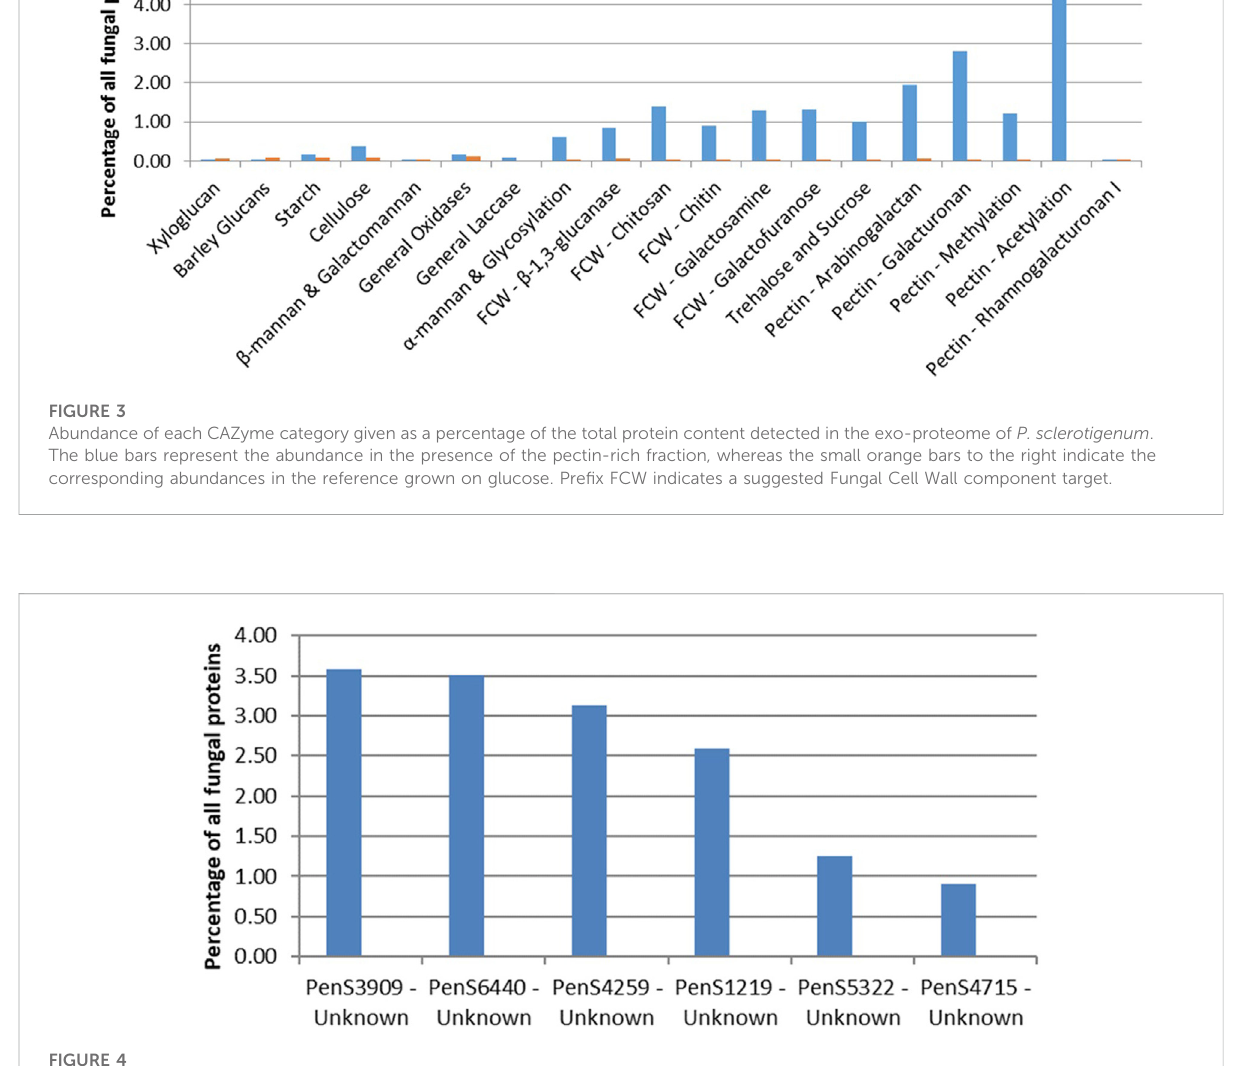
FIGURE 4 Protein abundances in the exo-proteome of six potentially new pectin active enzymes, all with predicted signal-peptide. The percentage level ofeachprotein,shownasbluebars,isgivenastheabundanceofthegivenproteinrelativetothetotalabundanceofallproteinsobservedintheexo- proteome of P. sclerotigenum . PenSxx-numbers refer to protein accession numbers. The protein accession numbers match accession numbers of speci fi c predicted proteins encoded by the genome of P. sclerotigenum (Supplementary Tables S1 and